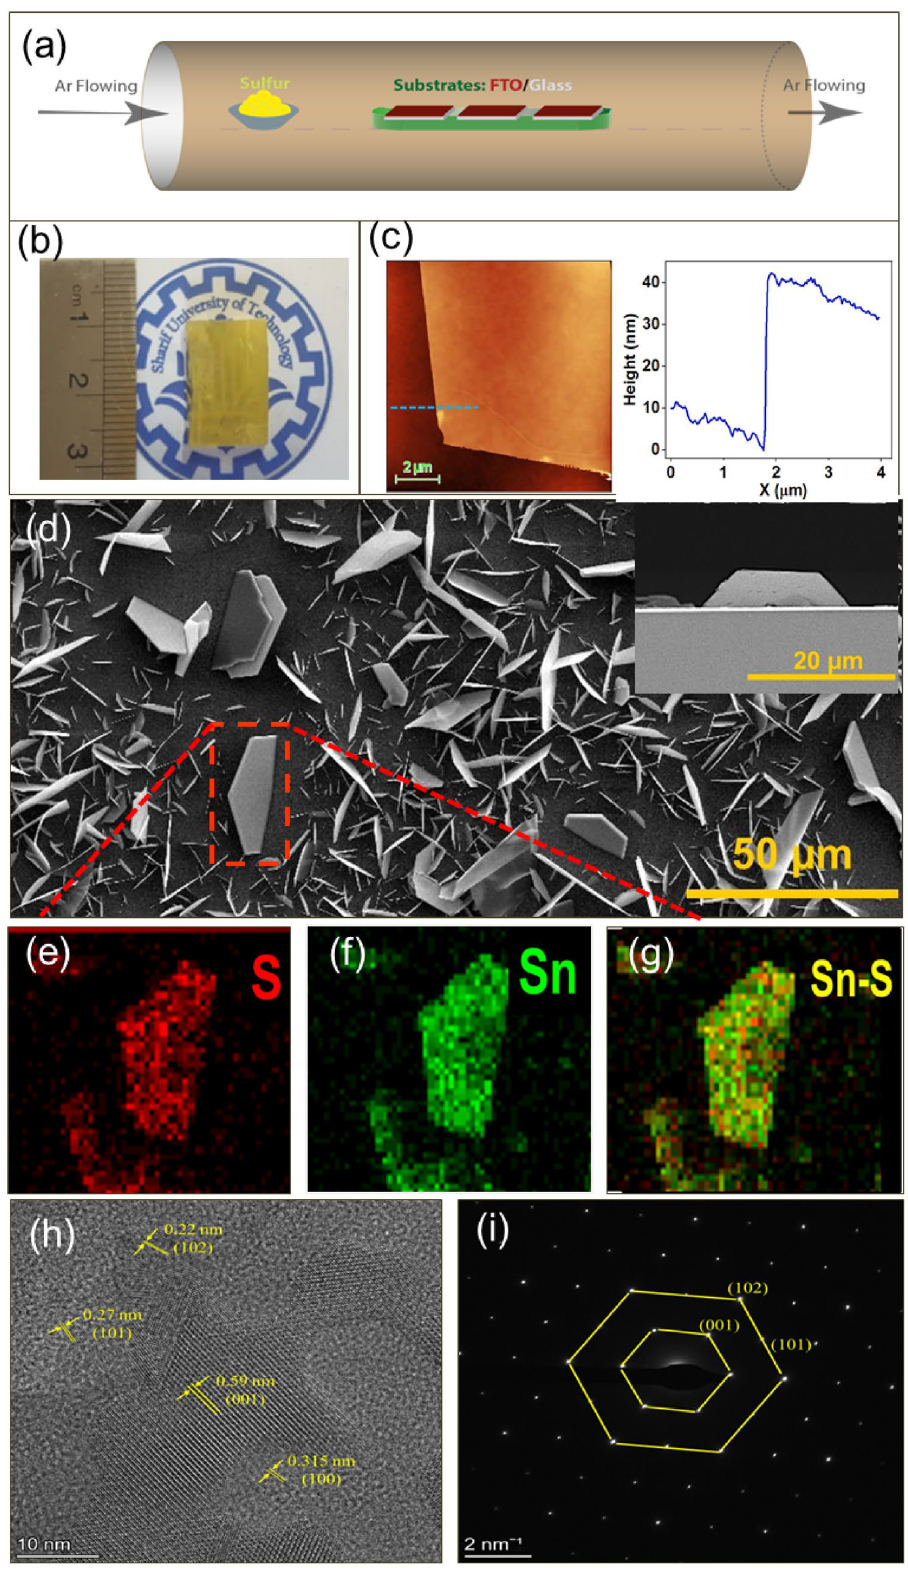
Figure 1. SnS 2 nanosheet growth structural charactrizations. ( a ) Schematic of modified CVD using the FTO/glass as both the substrate and the Sn source for growing vertically SnS 2 nanosheets. ( b ) Photograph of the sample of SnS 2 nanosheets on the large scale FTO/glass substrate. ( c ) AFM images of SnS 2 nanosheet on SiO 2 substrate and the corresponding height profile. ( d ) FESEM analysis of the typical SnS 2 nanosheets grown by CVD introduced by using 500 mg of sulfur source; the inset shows the l cross-section of 2D vertically SnS 2 nanosheets on the FTO/glass. Elemental mapping image of ( e ) S, ( f ) Sn and ( g ) Sn-S atoms for typically grown nanosheet on FTO/glass substrate ( h ) The HRTEM and ( i ) selected area electron diffraction (SAED) pattern of a part of SnS 2